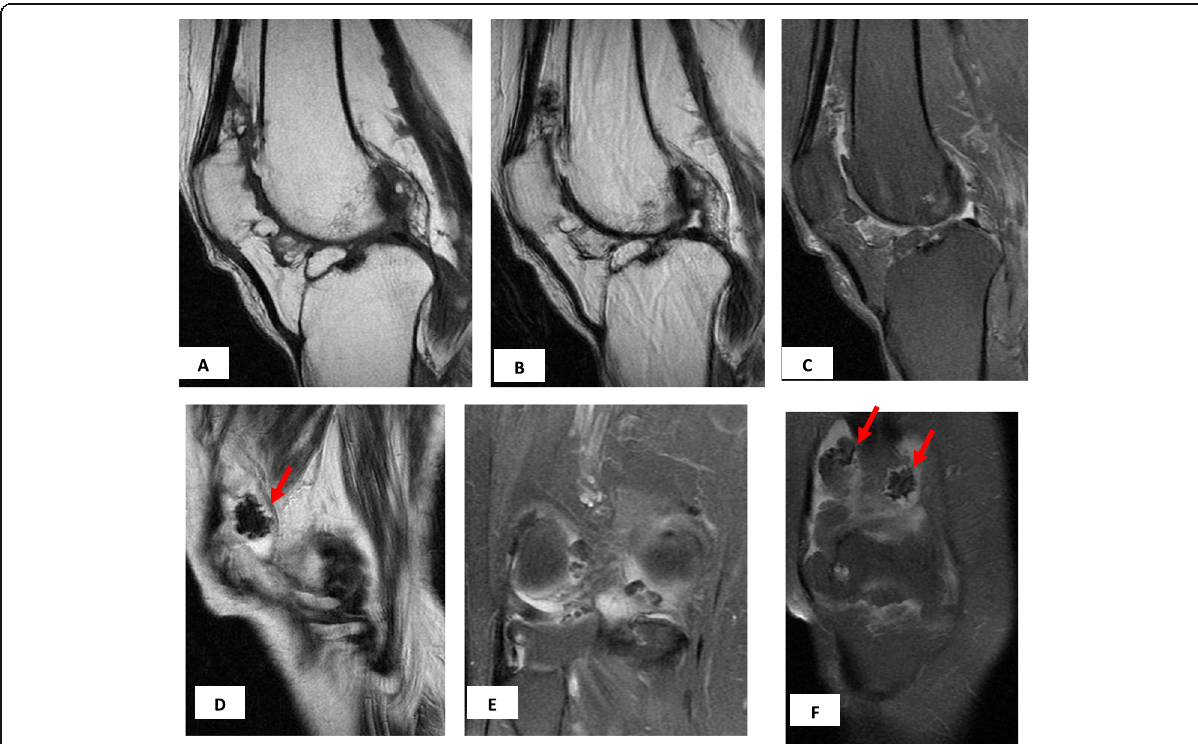
Fig. 3 Synovial chondromatosis in 58-year-old male with right knee osteoarthritis. Sagittal T1 ( a ), sagittal T2 ( b , d ), sagittal STIR ( c ), and coronal STIR ( e , f ) show low signal at T1, T2, and STIR calcified different size nodules (red arrows) with osteoarthritic